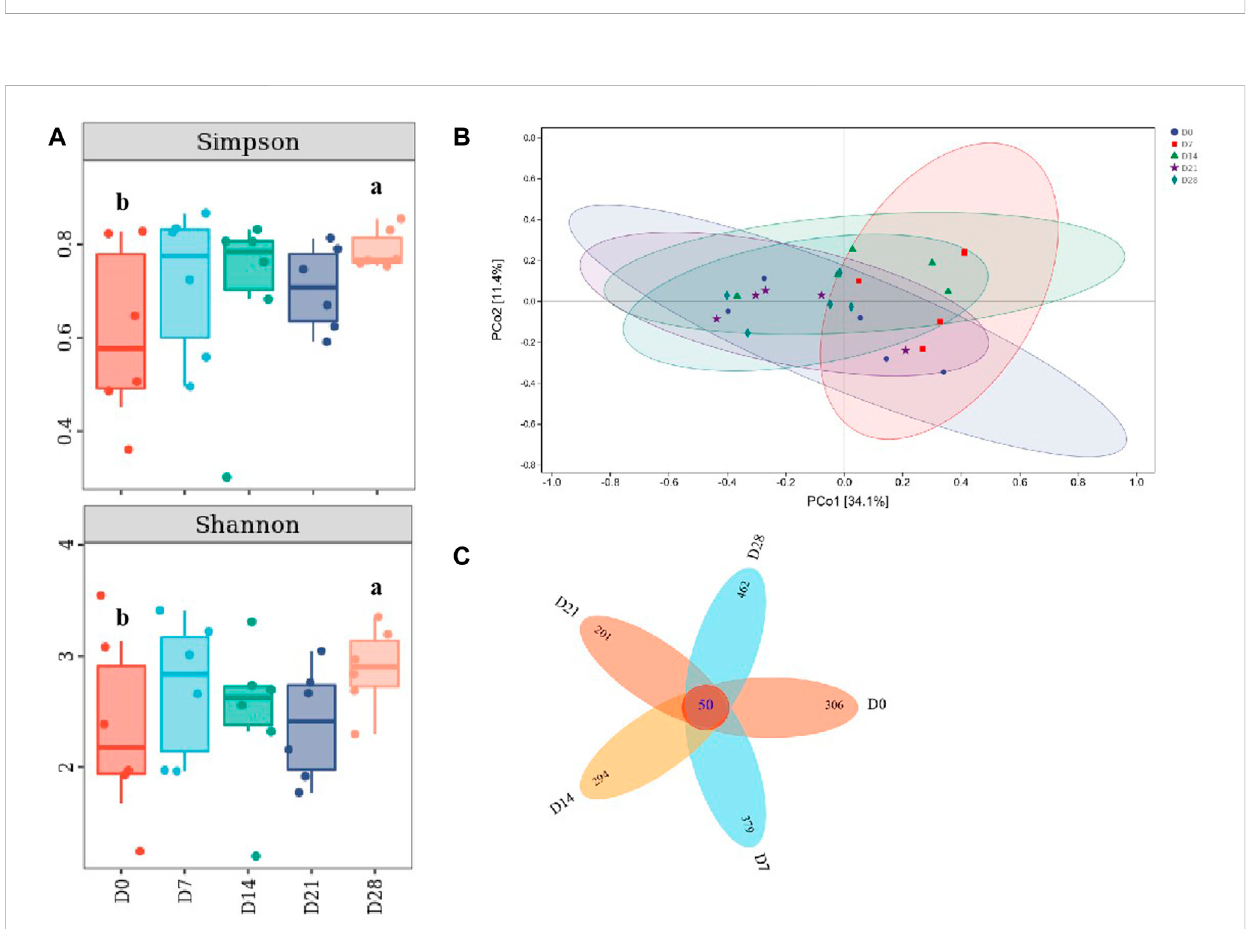
FIGURE 6 Effect ofdiapausetime on the diversity and species difference of gut microbiota in C.bilineatatsingtauica larvae. Simpson indexand Shannon index (A) of gut microbiota; PCoA analysis (B) ; the petals fi gure (C) of gut microbiota. Different lowercase letters denote signi fi cant difference among diapause time by Tukey test at p <